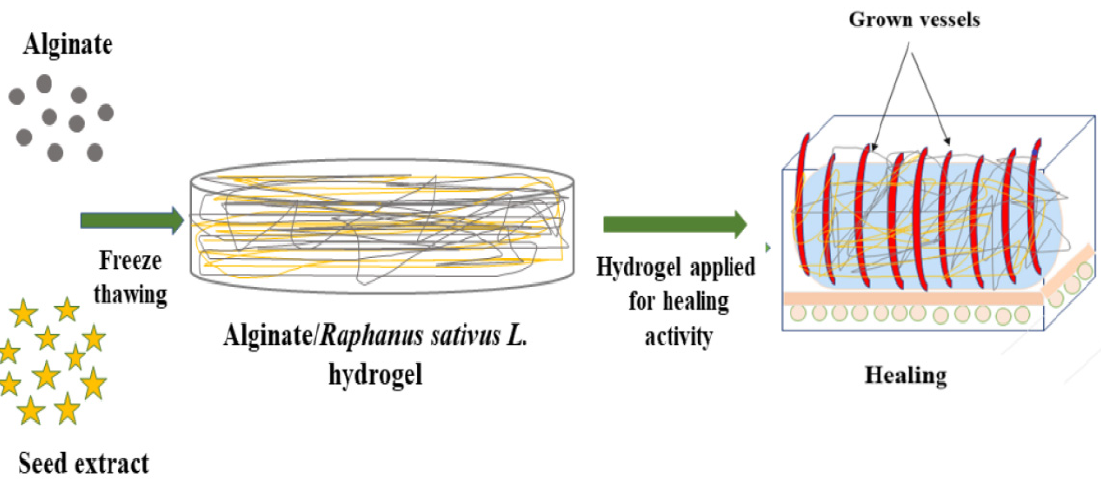
Figure 7. Schematic representation of SA-SE hydrogels.